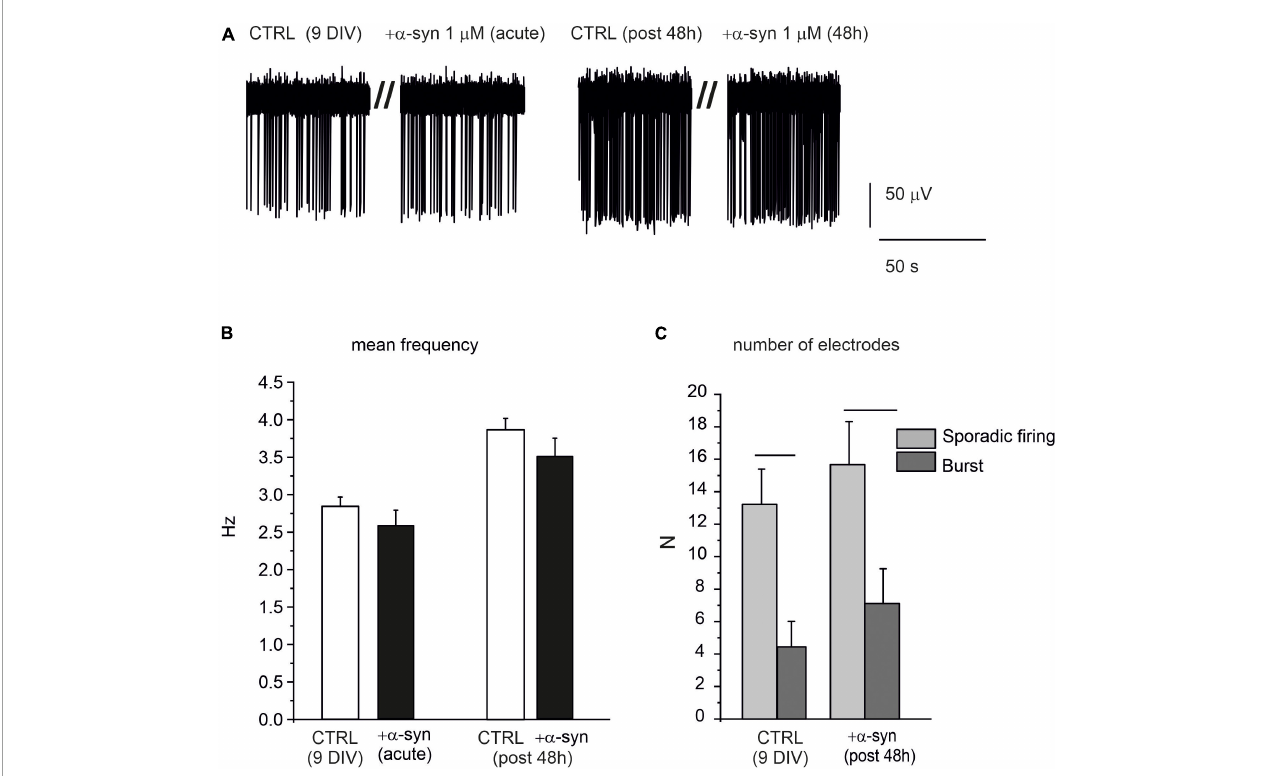
FIGURE11 α -syn does not affect the spontaneous activity of early developed neurons (9 DIV). (A) Representative traces of spontaneously firing neurons at 9 DIV, under control conditions (without α -syn) and after 48 h exposure to α -syn. Recordings were performed over 120 s. Only a part of the recording is shown here to better visualize the events. (B) Bar histograms show the mean values of the firing frequency without α -syn (CTRL), after acute addition and after 48 h exposure to 1 µ M α -syn. (C) Number of microelectrode arrays (MEA) electrodes detecting sporadic or burst activity. Statistical difference is indicated by the horizontal lines (CTRL, p = 0.005; α -syn post 48 h, p =